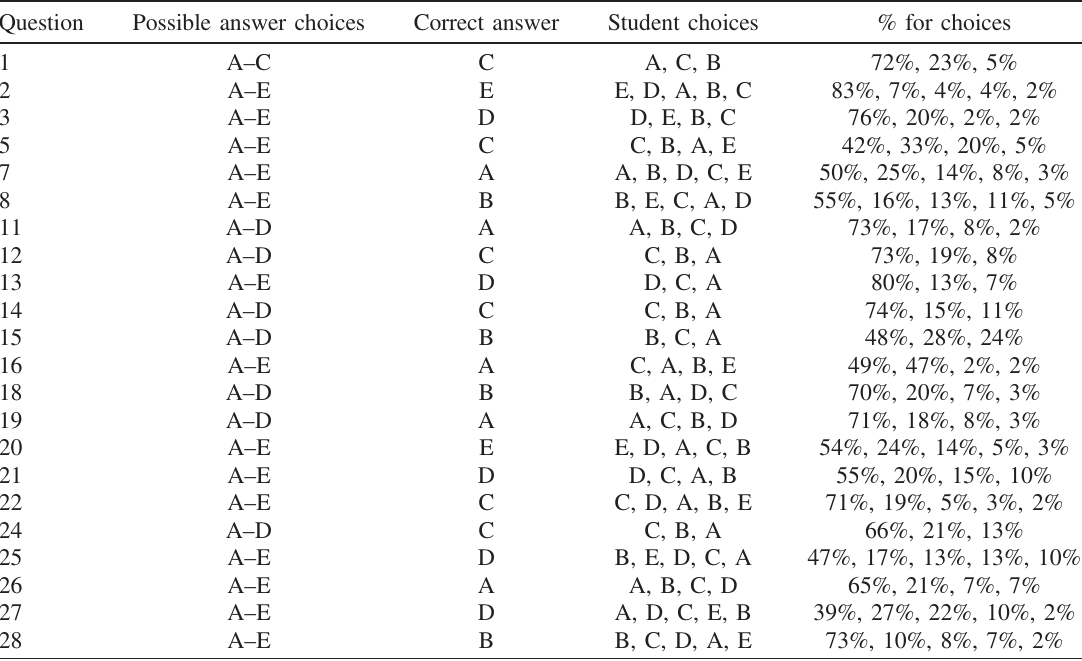
TABLE VIII. 2017 student answer